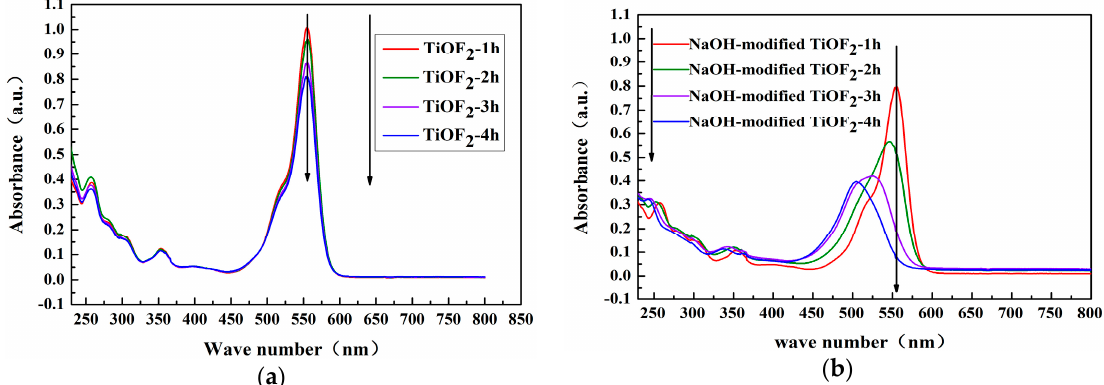
Figure 6. UV–vis absorption spectra of RhB in ( a ) TiOF 2 and ( b ) NaOH-modified TiOF 2 suspension under visible light.